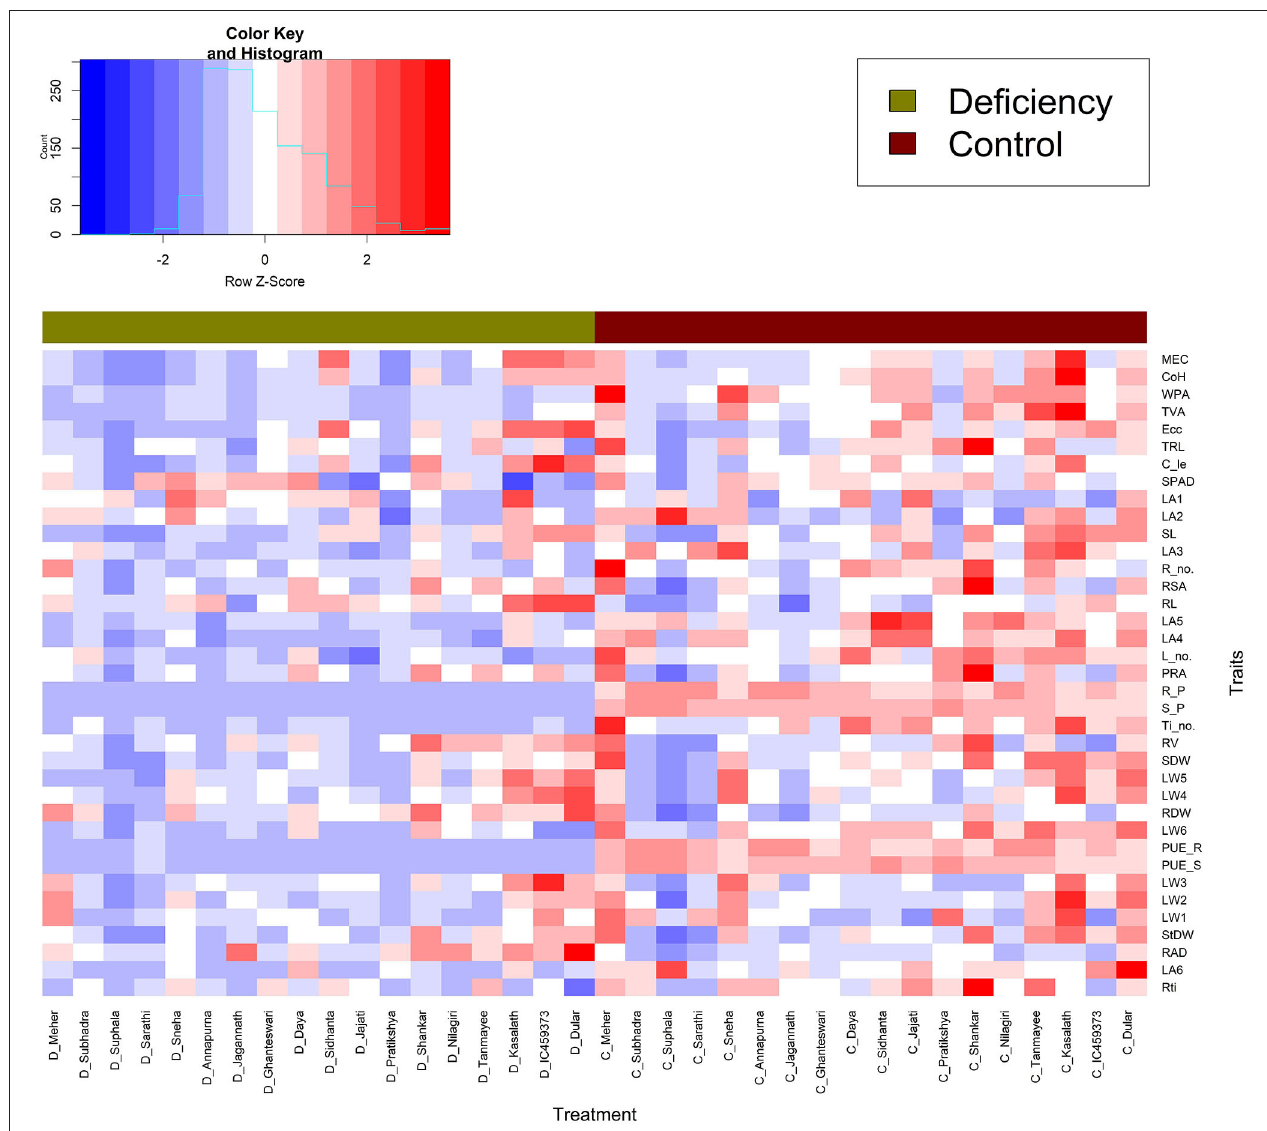
FIGURE 5 | Heat map of two treatments (control and deficit) of the 18 genotypes and 38 morpho-physiological and geometric traits. Each column represents a genotype, and each row represents a trait. The horizontal bar with two colours (olive and maroon) represents the treatment